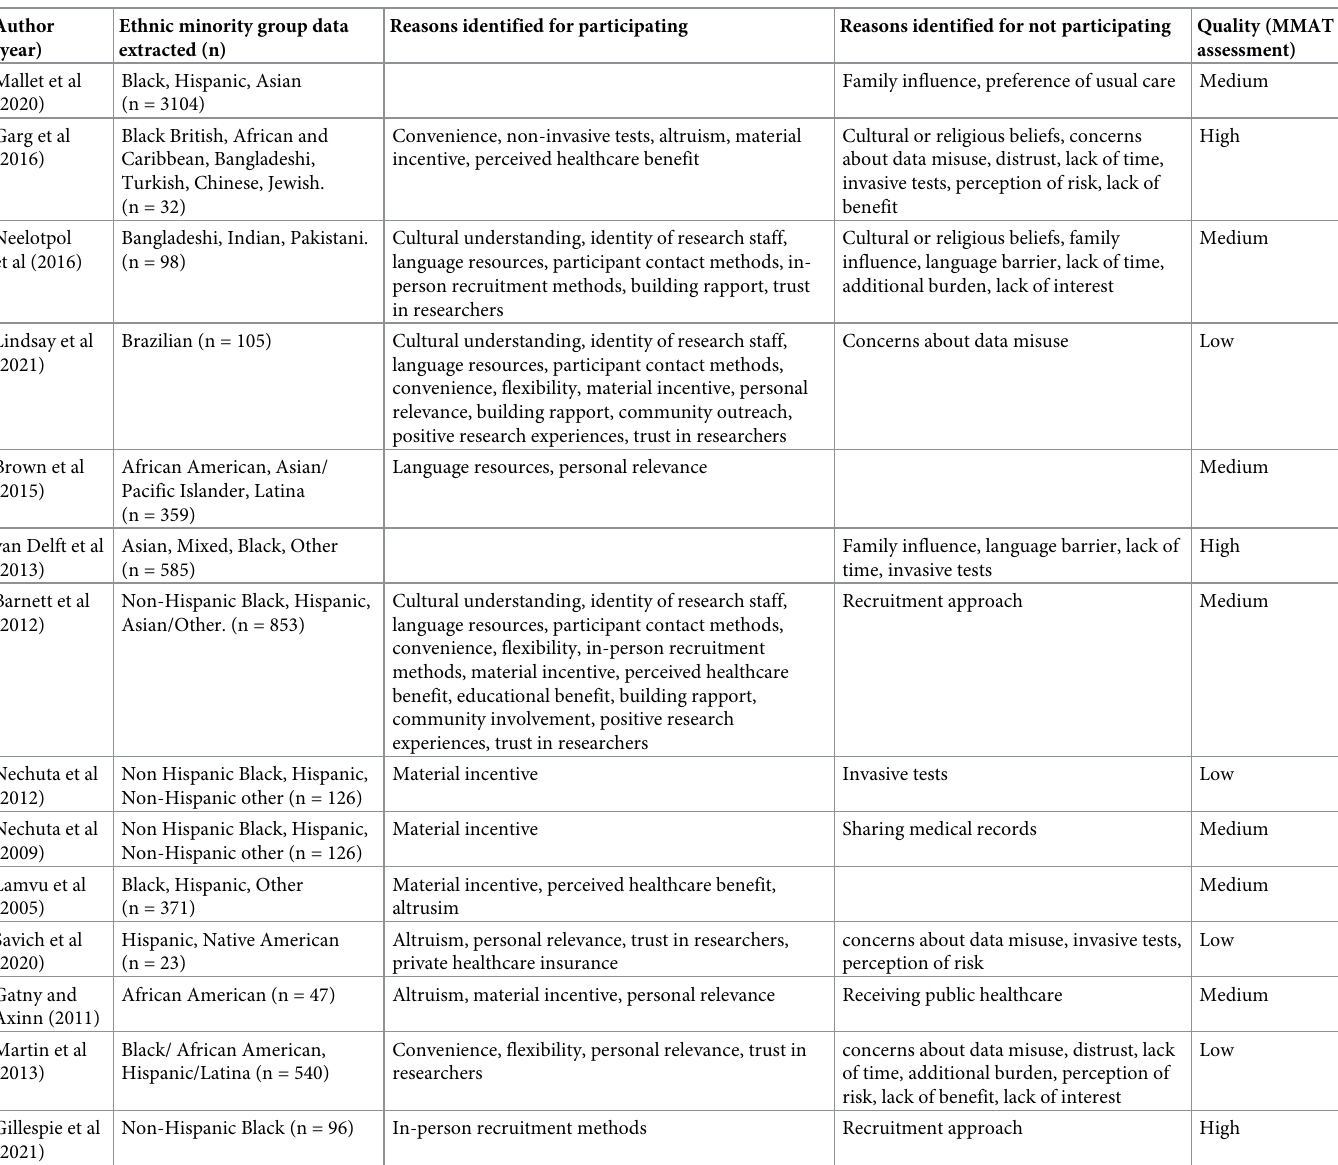
Table 4. Paper’s findings and quality